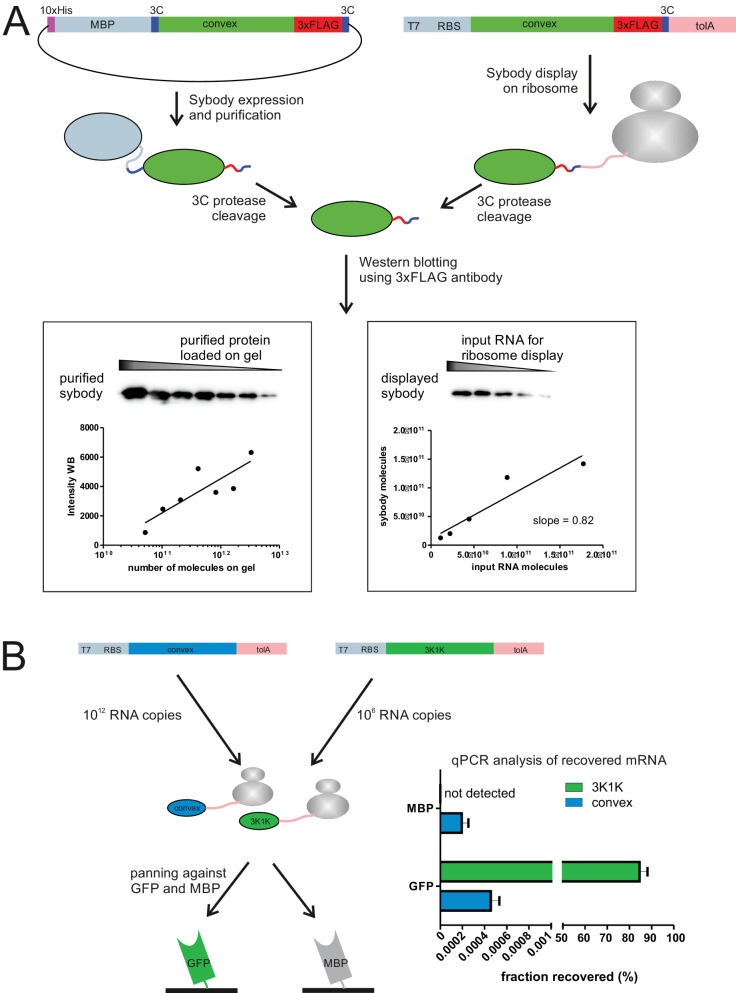
Ribosome display of single domain antibodies.(A) The non-randomized convex sybody was either purified containing a C-terminal 3x-FLAG tag or displayed on ribosomes containing the same tag using the commercial kit PUREfrexSS (GeneFrontier). 3C protease cleavage was used to liberate the displayed sybody from the ribosomal complex. Western blotting analysis using anti-3x-FLAG antibody and purified sybody as standard revealed a display efficiency of 82% of input mRNA for ribosome display. (B) 106 mRNA molecules encoding the GFP-specific 3K1K nanobody were displayed on ribosomes using PUREfrexSS together with 1012 mRNA molecules encoding the non-randomized convex sybody. The ribosomal complexes were pulled down using either biotinylated GFP or MBP immobilized on magnetic beads. The mRNA of isolated ribosomal complexes was isolated, reverse transcribed and the resulting cDNA was analyzed by qPCR performing technical triplicates. This analysis revealed that 84.6 ± 3.5% (error corresponds to standard deviation) of the input 3K1K mRNA was retrieved on GFP-coated beads, while virtually no background binding of the non-randomized convex sybody nor 3K1K binding to MBP was observed.